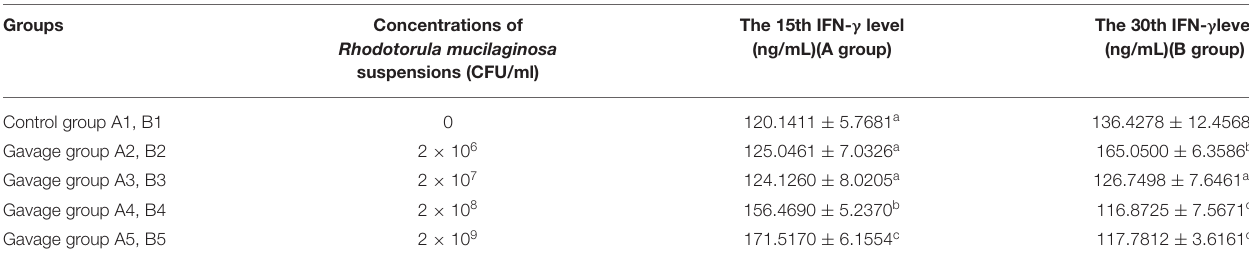
TABLE 5c | Effects of R. mucilaginosa on INF- γ content in mouse serum.